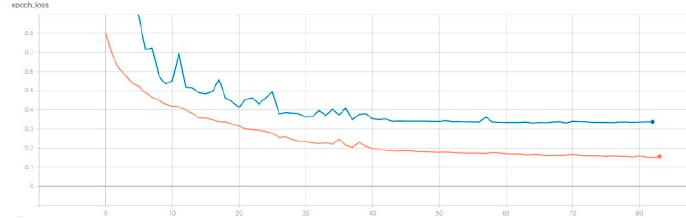
Figure 12. Loss curve.